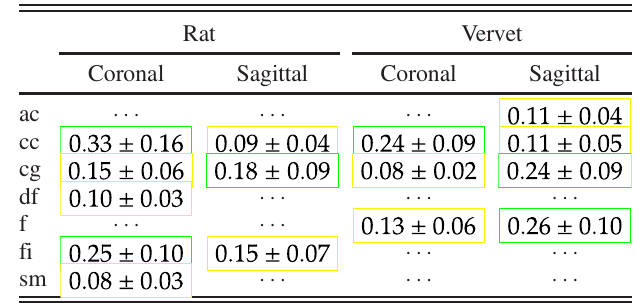
TABLE I. Mean transmittance values ( I deviation for the selected green and yellow areas in Fig. 11. Areas belonging to the same structure are evaluated together (cg ≡ cg 1 ∪ cg 2 ).